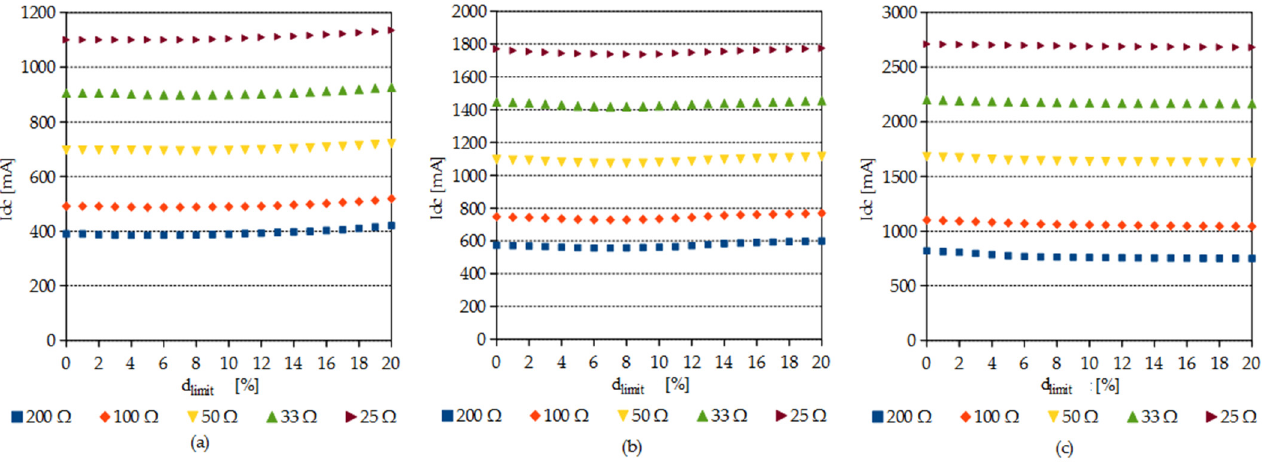
Figure 11. Input DC-link current measured at different load at ( a ) 1500 RPM, ( b ) 2000 RPM, and ( c ) 2500 RPM; I dc denotes the input DC-link current.